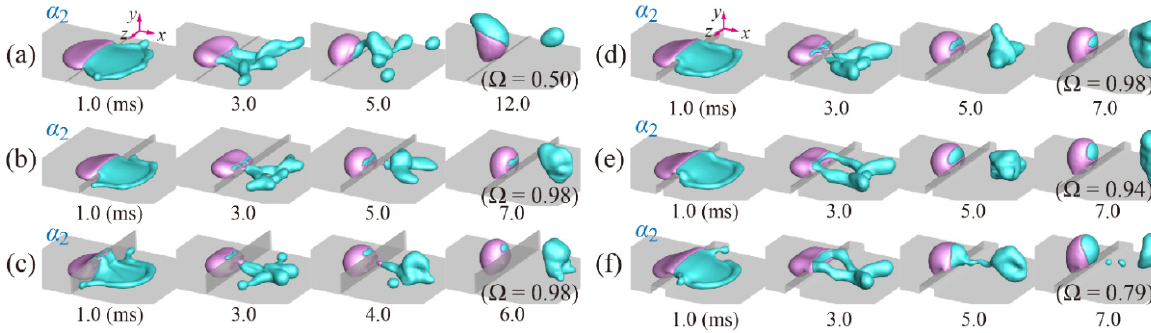
Figure A2. Shape evolutions of the drops on the ridged surfaces with ( a – c ) h / D 0 = 0.05, 0.2, and 0.5 and ( d – f ) w / D 0 = 0.1, 0.2, and 0.4 under the viscosity ratio of α 2 , respectively. The basic size of the ridge corresponds to h/D 0 = 0.2 and w/D 0 = 0.05. The drop’s diameter and Weber number in ( a – f ) correspond to D 0 = 2.0 mm and We w = 61.